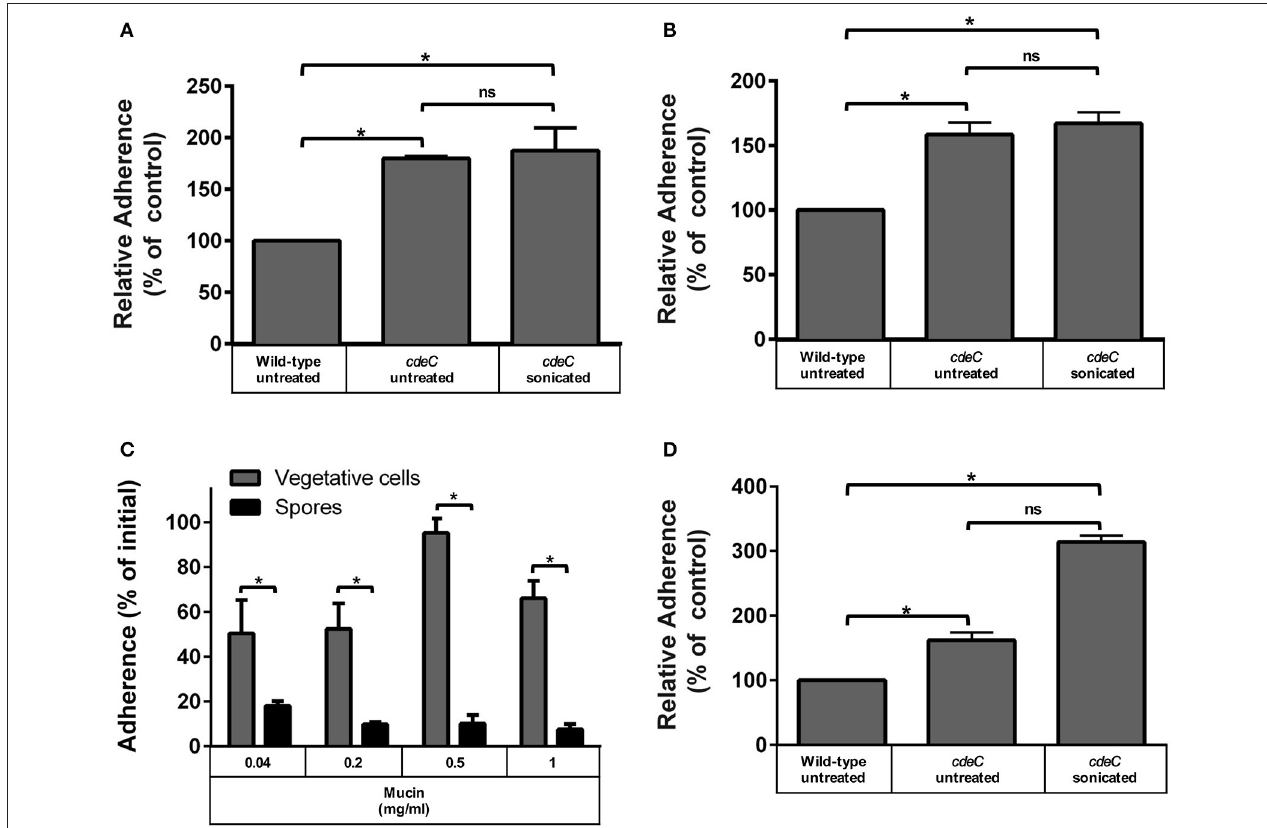
FIGURE 3 | Effect of the exosporium integrity on the tropism of C. difficile spores to intestinal epithelial cells and mucin. Monolayers of undifferentiated (A) and differentiated (B) Caco-2 cells, were infected for 1h at an MOI of 10 with C. difficile wild-type, untreated or sonicated cdeC mutant spores, unbound spores were rinsed off and adhered spores were quantified as described in the Method section. Data in (A,B) is expressed relative to the control which corresponds to the percentage of adherence of wild-type spores. Values are the mean of three independent experiments and error bars are standard error from the means. Asterisks (*) denote statistical differences with a P < 0.01; ns, not significant. (C) Adherence of C. difficile spores to mucin. The adherence of C. difficile vegetative cells (gray bars) and spores (black bars) to mucin was evaluated by incubating C. difficile vegetative cells or spores for 3h at 37 ◦ C in wells containing different concentrations of mucin and adhered spores were determined as described in the Method section. Data corresponds to the average of three independent experiments and error bars are standard error of the mean. Asterisks (*) denote statistical differences with a P < 0.01 (Student’s t -test). (D) C. difficile spores with a deficiently assembled exosporium layer exhibit increased adherence to mucin. Mucin-containing wells were infected with C. difficile wild-type spores, untreated or sonicated cdeC mutant spores, unbound spores were rinsed off and adhered spores were quantified as described in the Method section. Data is expressed relative to the control which is the percentage of adherence of wild-type spores. Data is the mean of three independent experiments and error bars are standard error from the means. Asterisks (*) denote statistical differences with a P < 0.01; ns, not significant (Student’s t